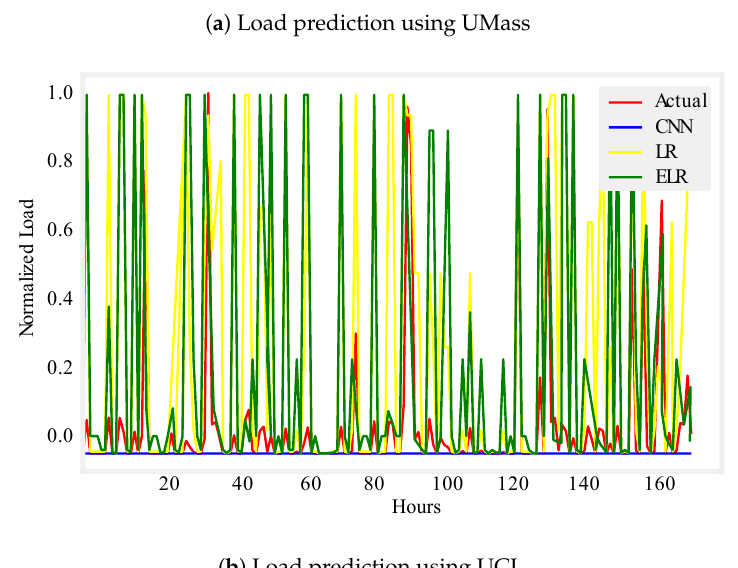
Figure 6. One week load